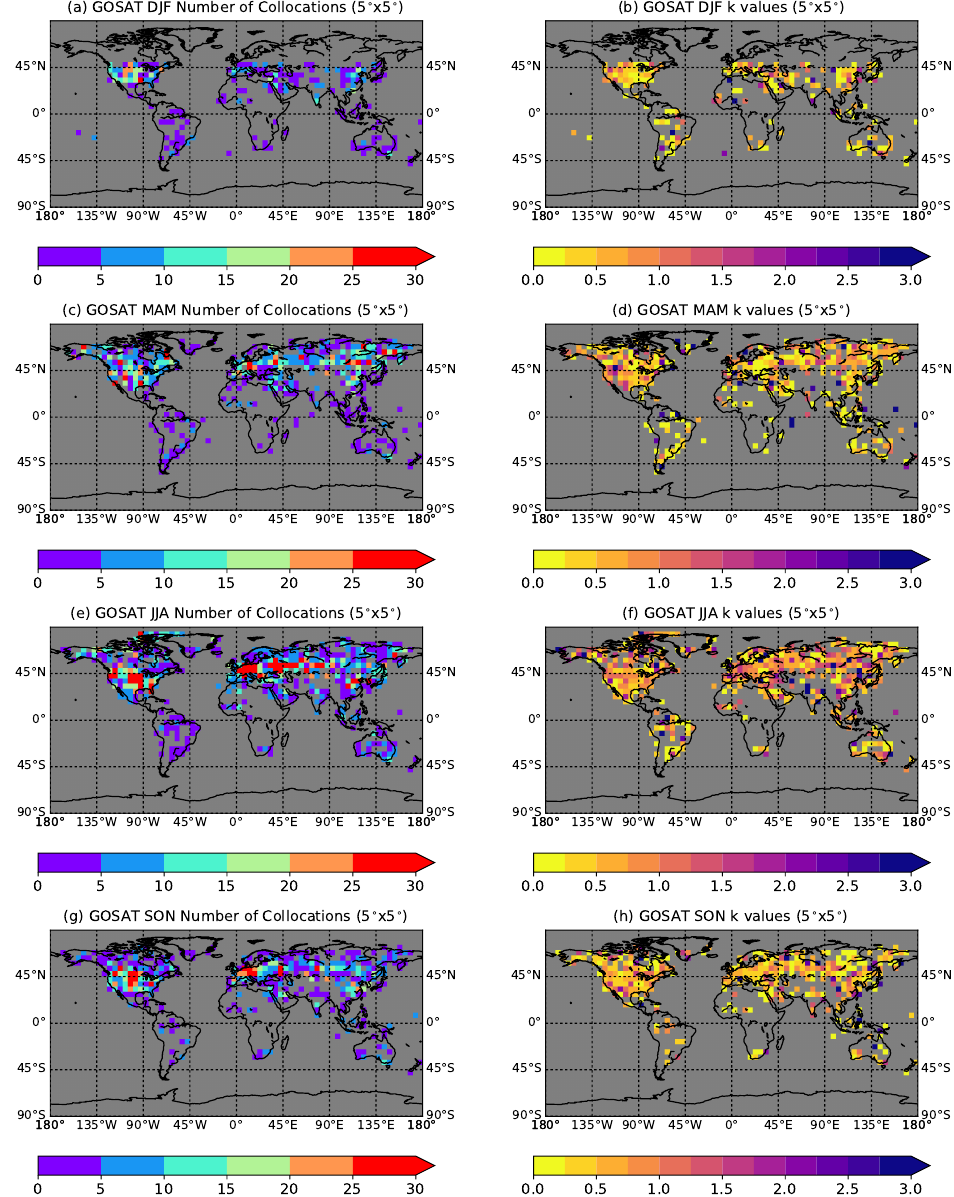
Figure 10. Seasonal collocation and k statistics for GOSAT and ARSA comparisons. Frames ( a , c , e , g ) show global distribution of matched cases as a function of season. North America, Central/Northern Asia and Europe can be seen as the dominate collocation areas. Frames ( b , d , f , h ) show the mean seasonal and global k (Equation (18)) value distributions. The majority of 5 ◦ × 5 ◦ cells reduce to below 2, i.e., they are in statistical agreement (Immler et al.